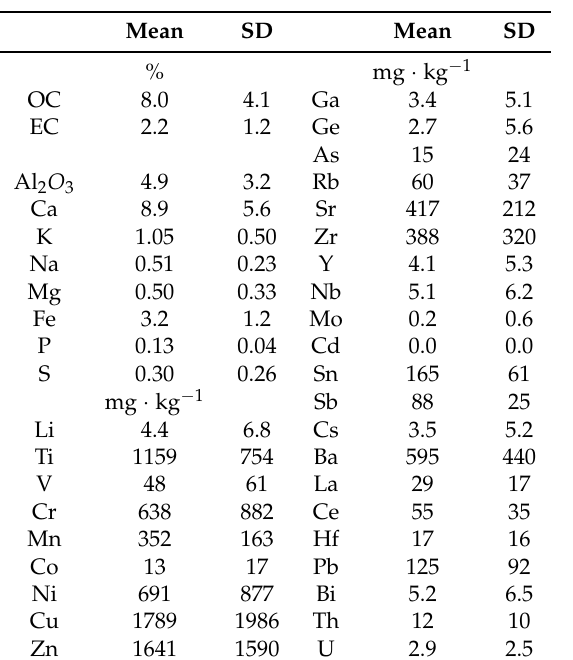
Table 5. Relative mean concentrations of major and trace components in RD10 samples and sum of determined species. The sum of the determined species is 30.6% of the total